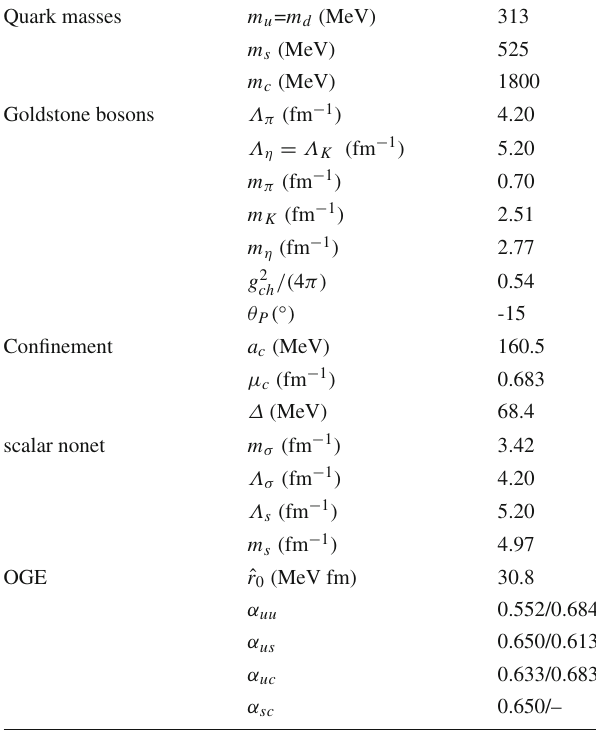
Table 1 Quark model parameters